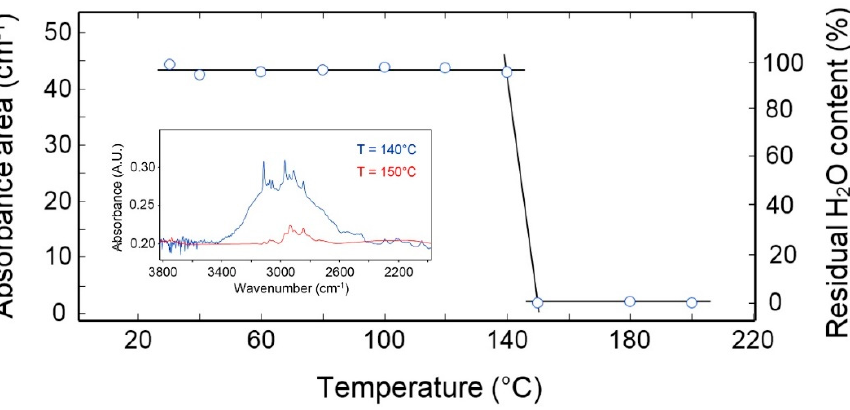
Figure 9. Absorbance area of the H 2 O band at 3000 cm − 1 and residual water content in the sample as a function of temperature. The inset compares the FTIR spectra in the 3800–2000 cm − 1 range collected at 140 °C (blue trace) and 150 °C (red trace).